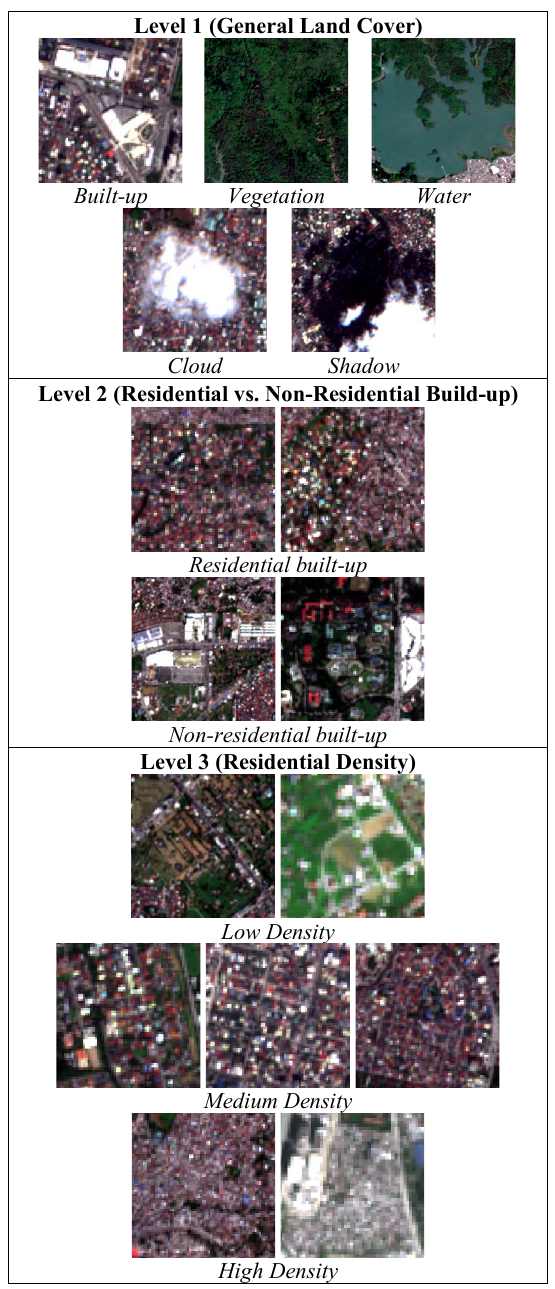
Figure 3. Sample Sentinel-2 image subsets for each land use land cover class in different levels of classification Five (5) classes were identified in Level 1 or the general land cover processing: built-up, vegetation, water, cloud, and shadow. Level 2 focused on the classification of built-up cover, by separating the residential and the non-residential cover. Elements analyzed in categorizing the built-up cover were color, shape, size pattern, and association. The location and presence of shadows were also examined to delineate non-residential